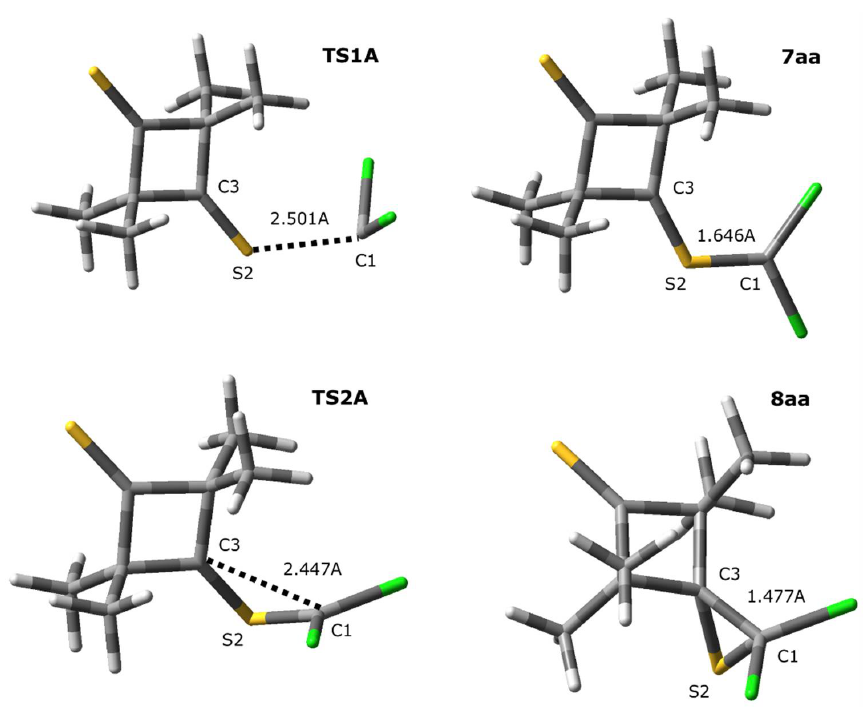
Figure 4. Views of key structures for 1a + 2a → 8aa transformation, in the reaction starting with